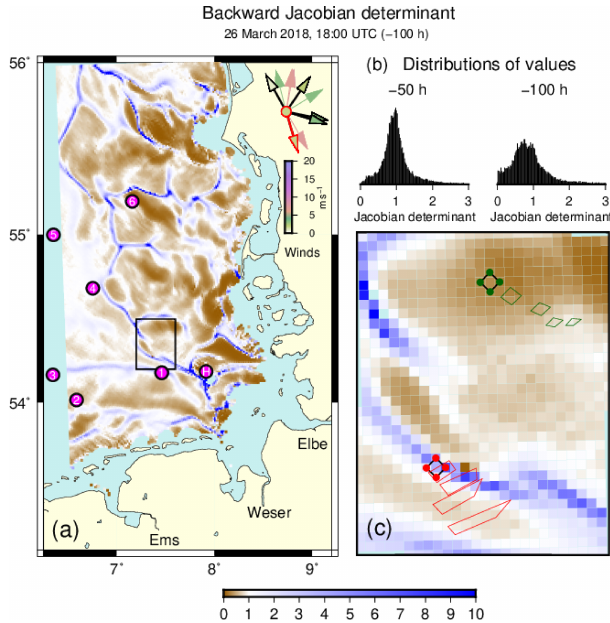
Figure 6. (a) Values of the Jacobian determinant (Eq. 3) for 100h backward simulations, initialized on 26 March 2018 (as in Fig. 3b). The few outliers exceeding the maximum value of the colour map were not specifically marked. Any negative values that occurred due to finite initial distances were omitted in the plot. Wind direc- tions during the integration time are shown at 10-hourly intervals in the top-right corner of the panel. The actual wind vector is out- lined in red, and those during the last 50h are outlined in black. (b) Histograms of Jacobian determinant values on the map for in- tegration times of − 50 (left) and − 100h (right) respectively. Note that the distributions’ flat tales extend beyond the ranges of val- ues shown. (c) Zooming in on the subregion indicated by the black frame in panel (a) , this panel shows the time evolution of two square patches, the corners of which are made up by the initial locations (red and green dots) of the four trajectories needed to calculate the discretized deformation gradients (Eq. 2) at the squares’ centres. The developments of deformed quadrangles during the − 100h in- tegration period are shown at 25-hourly intervals. Factors of area increases or decreases, µ 1 µ 2 (Eq. 3), are 1.56, 2.50, 3.40 and 3.73 (red) and 0.96, 0.70, 0.42 and 0.31 (green), where the last values equal the values shown in the map. The corresponding stretches, µ 1 /µ 2 , are 1.88, 3.01, 3.78 and 5.52 (red) and 1.17, 1.52, 1.98 and 2.36.